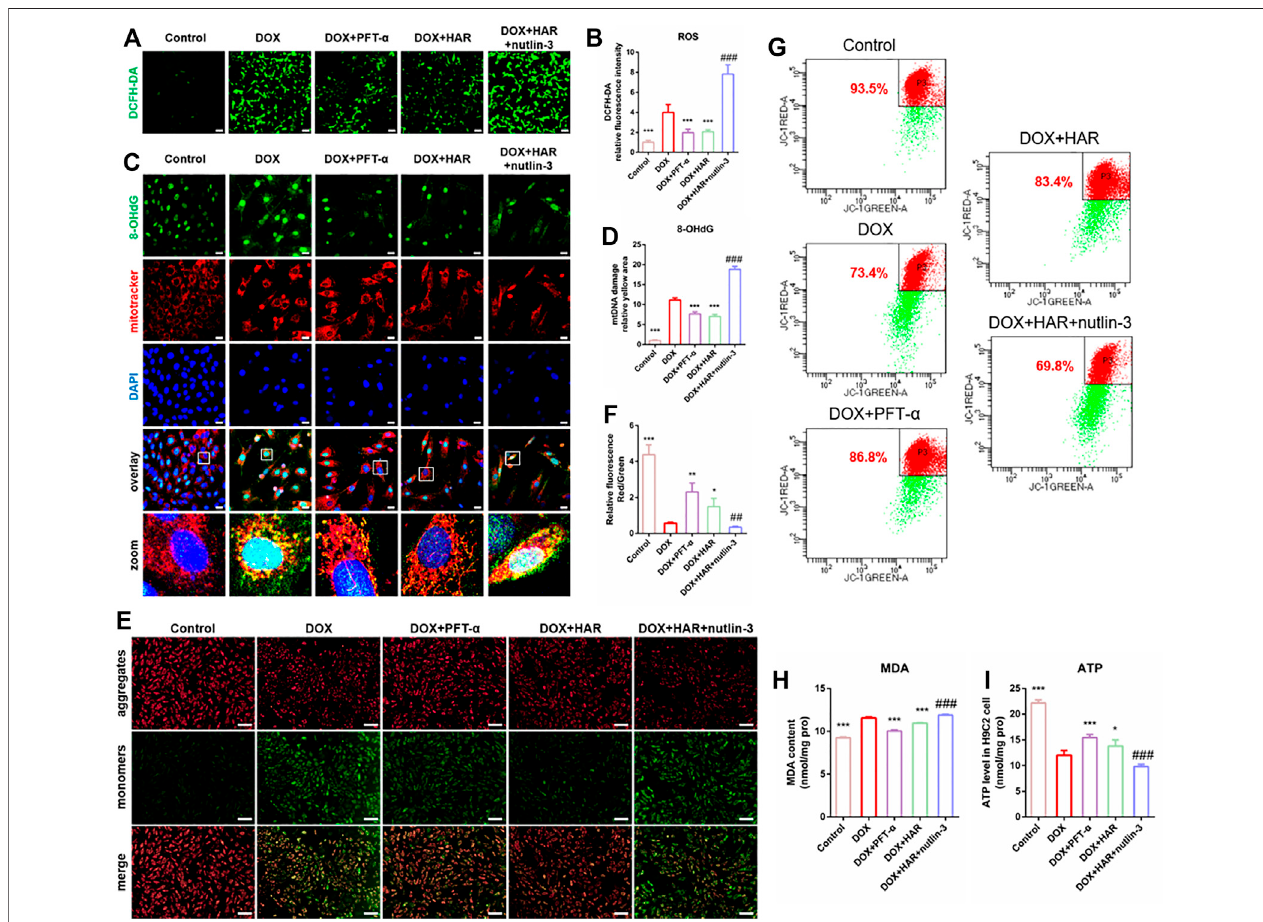
FIGURE 5 | HAR maintained mitochondrial health by suppressing p53 in vitro . (A – D) Representative images and quantitative analysis of ROS in H9C2 cells measuredbystainingwithDCFH-DAandmtDNAinjurymeasuredbycostainingwith8-OhdG(DNAdamagemarker)andMitoTracker( n =6).Scalebars:100and25 μ m. (E – G) Representative images and quantitative analysis of mitochondrial membrane potential in H9C2 cells measured by staining with JC-1 and detection under a fl uorescence microscope and fl uorescence-activated cell sorting ( n = 4 – 6). Scale bar: 100 μ m. (H) MDA was quanti fi ed in H9C2 cells to evaluate the degree of damage to intracellular membrane structures ( n = 6). (I) The intracellular ATP content in various groups of H9C2 cells. ATP content re fl ects mitochondrial productivity. * p < 0.05, ** p < 0.01, *** p < 0.001 vs. DOX group ( n = 3 – 6). ## p < 0.01, ### p < 0.001 vs. (DOX + HAR) group. The data are shown as the mean ± s.d.